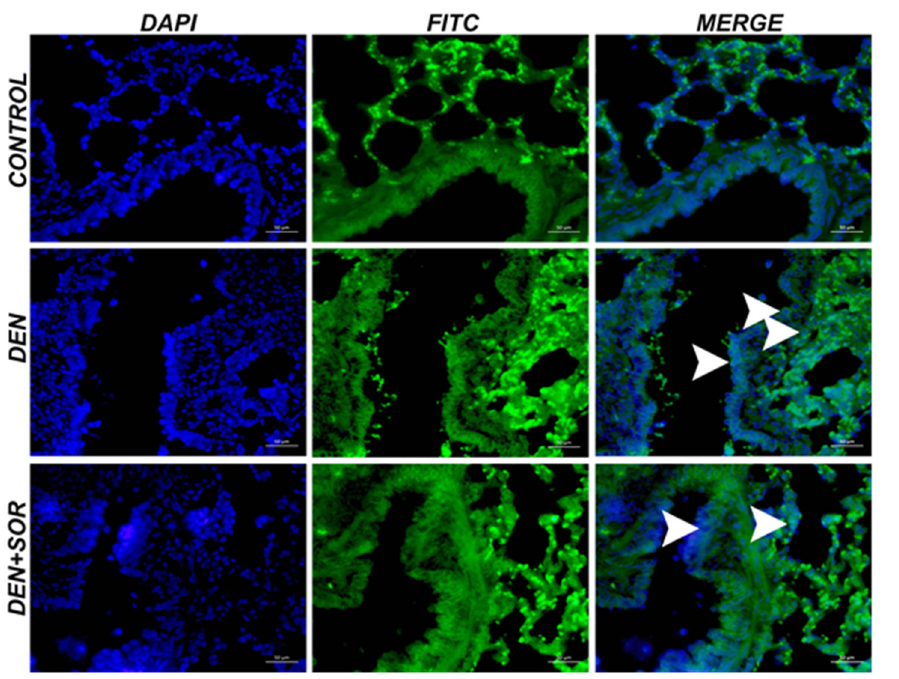
Figure 6. Immunofluorescence staining of JNK in experimental groups in lung tissue (×40), Bar: 50 µm. Control group, negative JNK expression; DEN group, Intracytoplasmic expression of JNK in epithelial cells due to the effect of the carcinogen DEN on the lungs (arrowhead); DEN + SOR group, JNK expression (arrowhead). Control: healthy group (no treatment), DEN: diethylnitrosamine group, DEN + SOR: DEN + 10 mg/kg sorafenib. Table 3. Scoring immunofluorescence results for lung tissues.